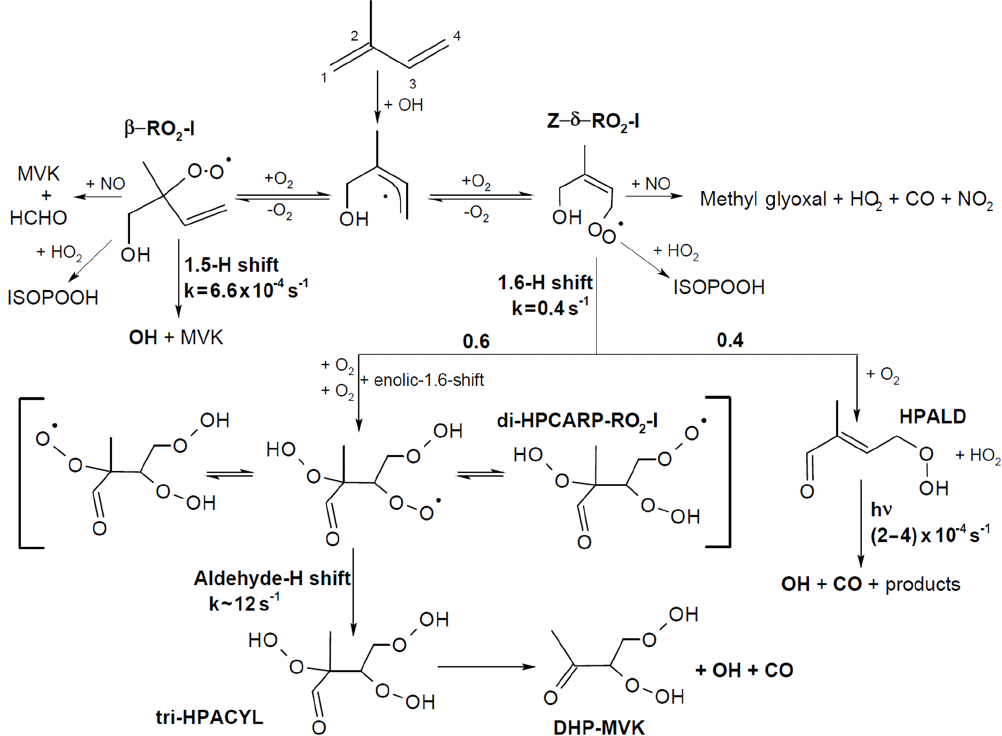
Figure 2. Simplified reaction schematic following OH addition to isoprene on the carbon C1. Only the most relevant reaction paths for OH radical formation are shown; the implemented mechanism includes all six isoprene-RO 2 isomers. The schematic illustrates the RO 2 unimolecular H shift reactions (1,5-, 1,6-, and aldehyde-H shifts), but all RO 2 species undergo competing reactions with NO, HO 2 , and RO 2 radicals (not shown), and the reaction steps shown can represent multiple fast, sequential elementary reactions. The rate coefficients and yields shown are obtained from the theoretical work from this study and from recent experimental and theoretical studies. The same yields for the product of the 1,6-H shift, rate coefficient of the aldehyde-H shift, and photolysis frequencies for HPALD are applied to the chemistry following the OH addition on C4. All rate coefficients are shown for 298K and a 30 ◦ solar zenith